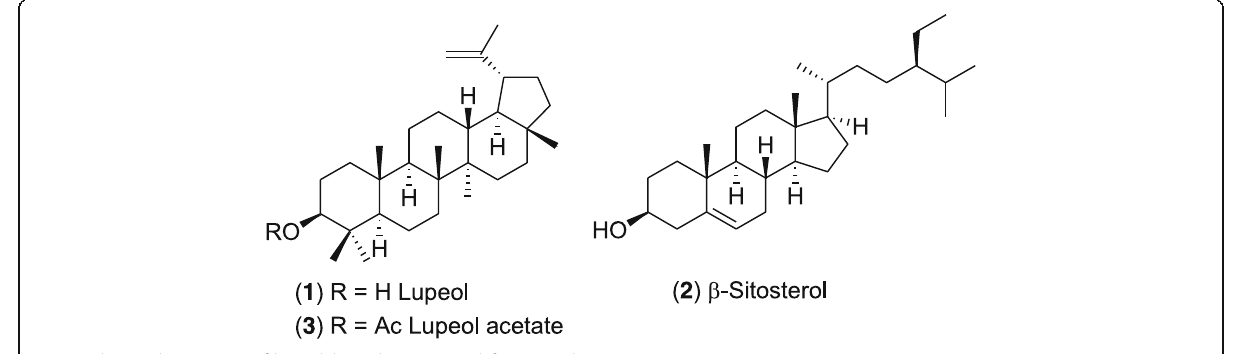
Fig. 1 Chemical structures of lupeol, lupeol acetate and β